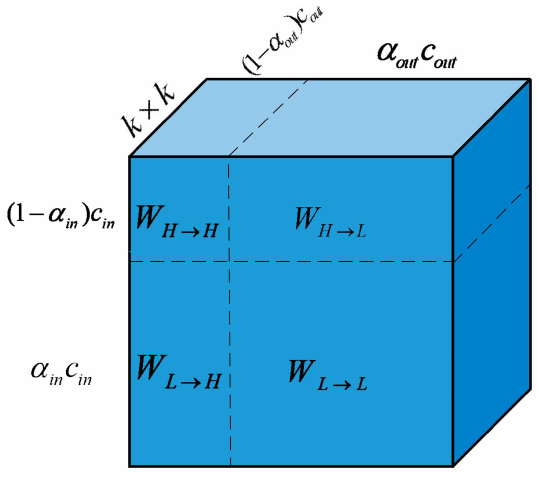
Figure 3. Schematic diagram of octave convolution. For the high-frequency feature map, regular convolution is used at position ( p , q ) . For inter-frequency communication, the low-frequency feature map is connected with the high-frequency feature after upsampling, and the process can be represented as